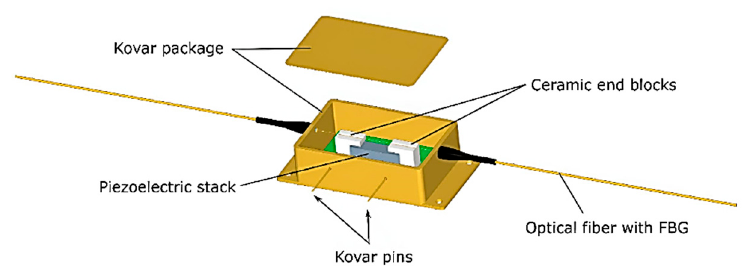
Figure 2. Low voltage transducer (LVT).